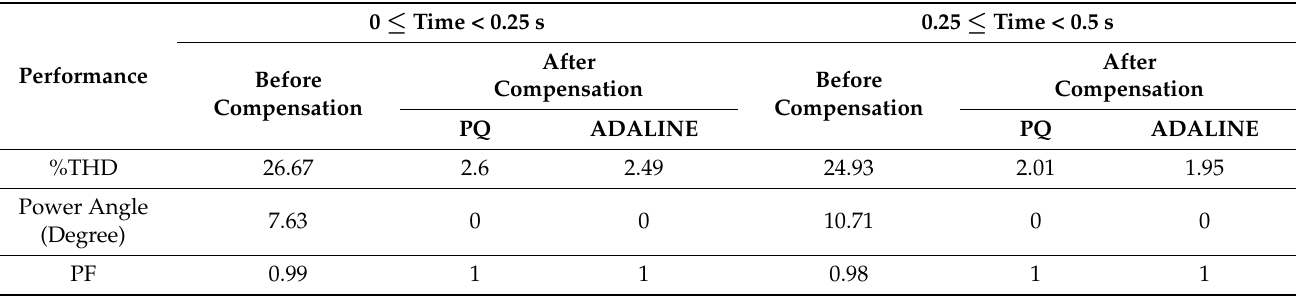
Table 4. The average performance value for Case